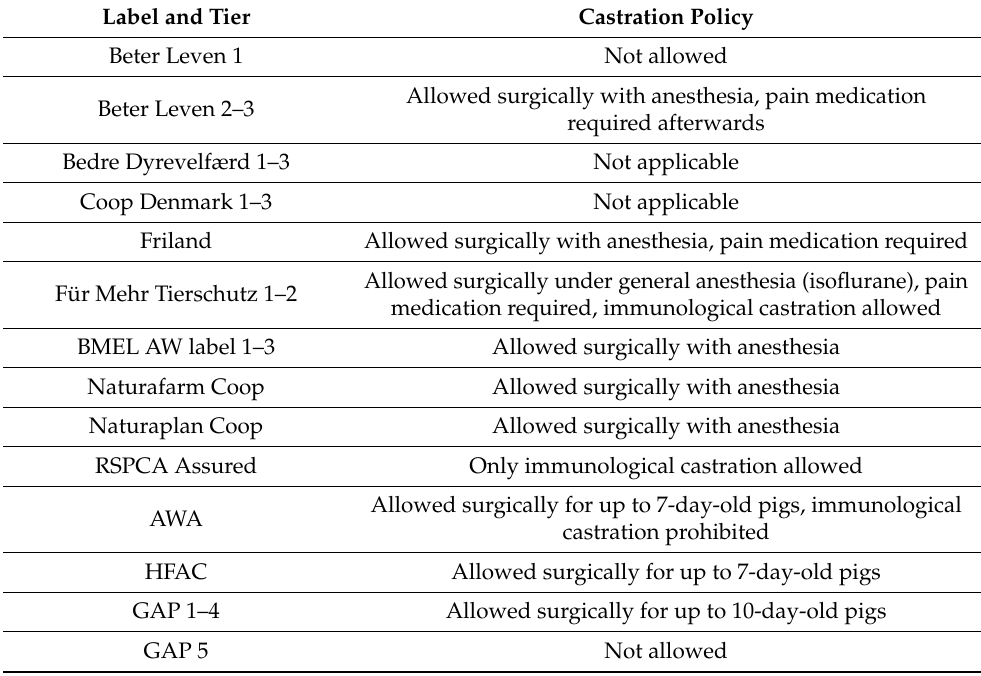
Table 3. Criteria for male pig castration in reviewed animal welfare labels. Label and